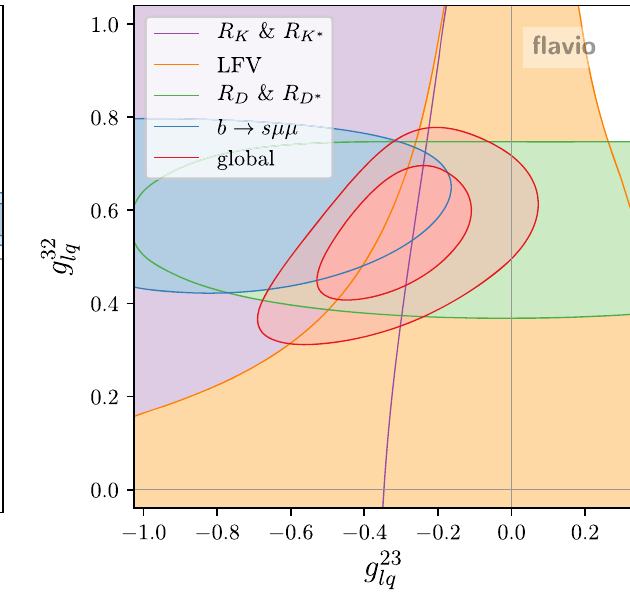
Fig. 6 Left:likelihoodcontoursinthespaceofthetwoSMEFTWilson coefficients that correspond to modified Z couplings to left- or right- handed top quarks. The constraints from flavour physics (dominated